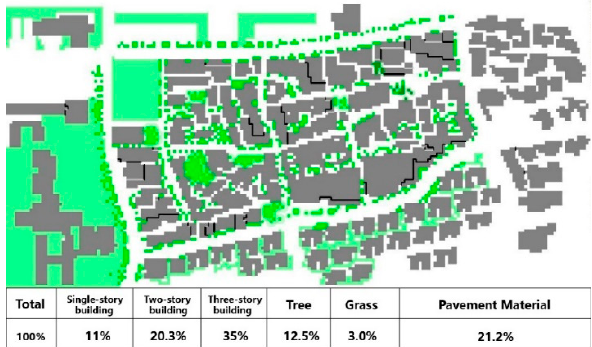
Figure 11. Various types of different coverage ratios of the base case.